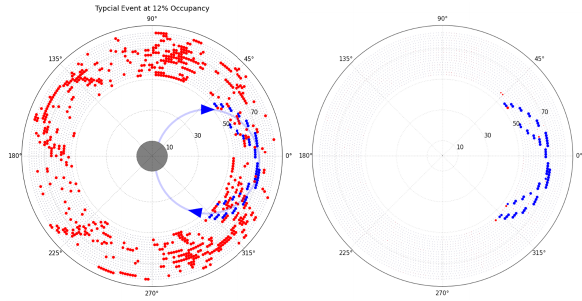
Figure 1. Cartoon of the delayed window technique. The prompt backgrounds (blue) should all occur a few hundred nanoseconds after the primary beam time, while the signal occurs according to the lifetime of the muonic atoms, which is matched to the bunch frequency. An important aspect is whether there are non- negligible o ff -time bunches (grey fill). In reality, such a back- ground is not expected to be a problem, as described in the next section.